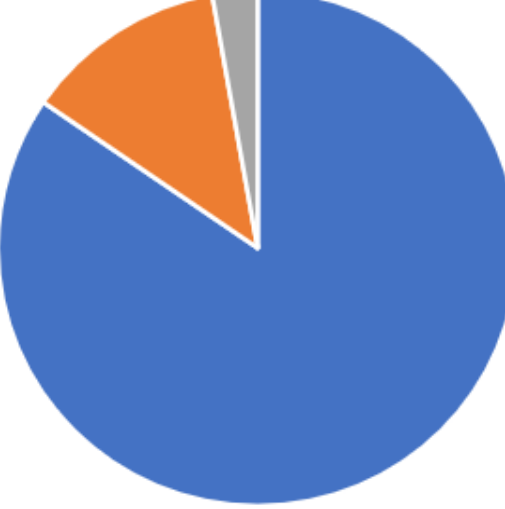
Figure 1. COVID-19 in Norway from March–June 2020.